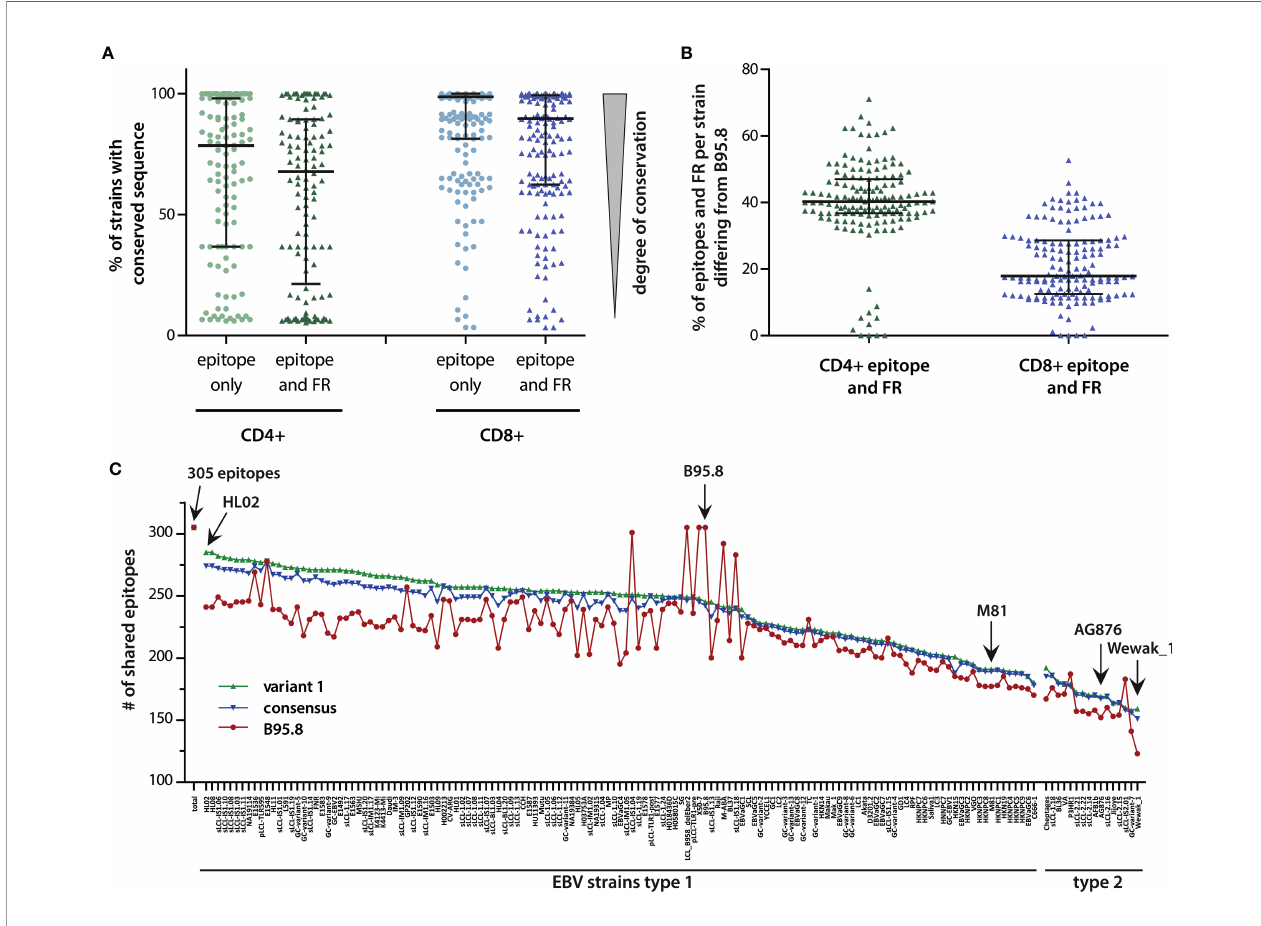
FIGURE 2 | Variability of T-cell epitopes among viral strains. (A) Percentage of EBV strains with conserved sequence for each CD4+ or CD8+ T-cell epitope, with and without fl anking regions (FR). Each dot represents one epitope. Median including 25% and 75% percentiles are shown. (B) Percentage of epitopes including fl anking regions, in which a given strain differs from B95.8. Median (black bar) with interquartile ranges (grey bars) are shown. (C) Number of epitopes shared by viral strains with epitope libraries. Shown in red are the number of epitopes plus fl anking regions shared by individual viral strains with B95.8. Depicted in green and blue are the number of epitopes including fl anking regions shared by individual strains with the “ variant 1 ” and “ consensus ” libraries, respectively. “ Variant 1 ” consists of those epitope variants most frequently found in all viral strains analyzed (epitope variant1, Table S3 ). The “ consensus ” library of T-cell epitopes was established by selecting those amino acids for each amino acid position of the epitopes that were found most frequently in all viral isolates ( Table S5 ). For incompletely sequenced strains, the number of epitopes was normalized (number of shared epitopes multiplied by 305 and divided by the number of epitopes analyzed in this strain). Besides B95.8, the NPC-derived type 1 strain M81, the prototypic type 2 strain AG876, and the in all analyses most incongruent strain Wewak_1 are marked with